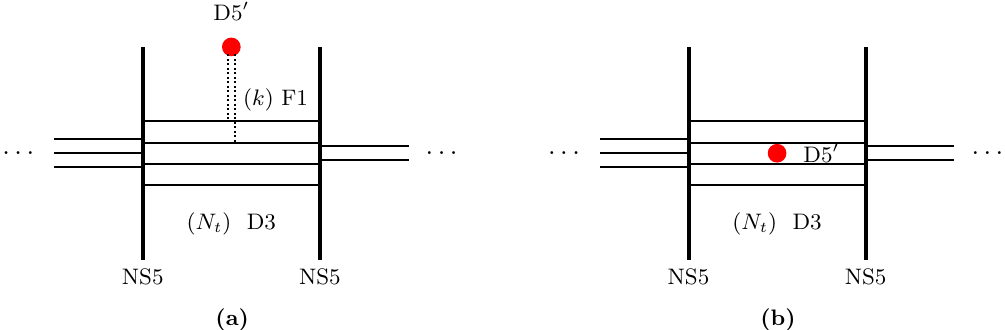
Figure 3. Brane realization of Wilson loops in the rank k antisymmetric representation of the t th gauge node. For simplicity we show a gauge node with no D5-branes representing fundamental matter. The Wilson loop is realized by k fundamental strings stretched between the D3 branes and a D5 0 brane, as shown on the left. Via Hanany-Witten moves, the D5 0 can be brought inside the D3 stacks, annihilating all the F1s, as shown on the